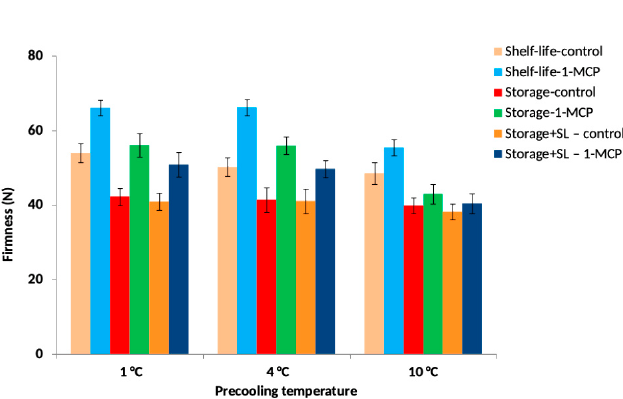
Fig. 3: Firmness during experiment (SL: shelf-life). Presented values are mean ± SD.